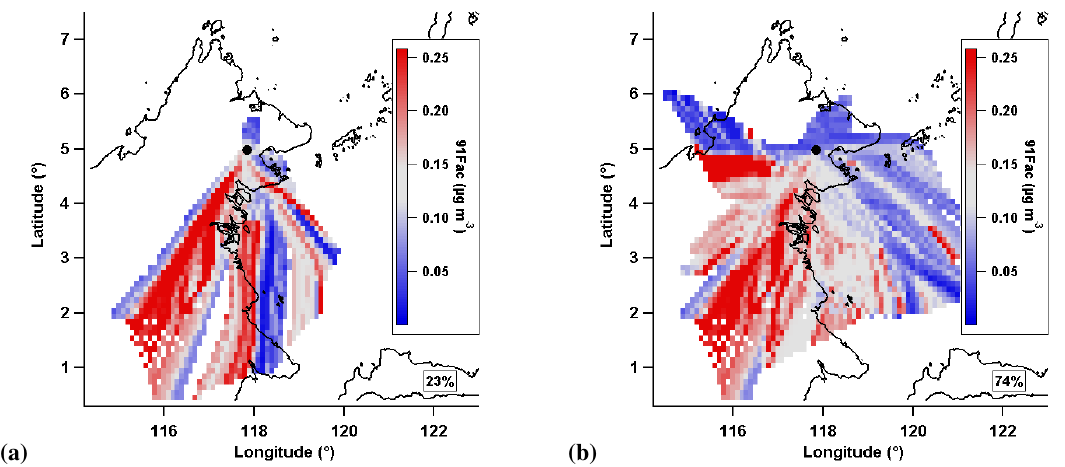
Fig. 19. Mean value maps of 91Fac during (a) POI 1 and (b) POI 2. Colour scale is the consistent between plots and is centred round the median value of the 91Fac mean value map for the whole campaign.